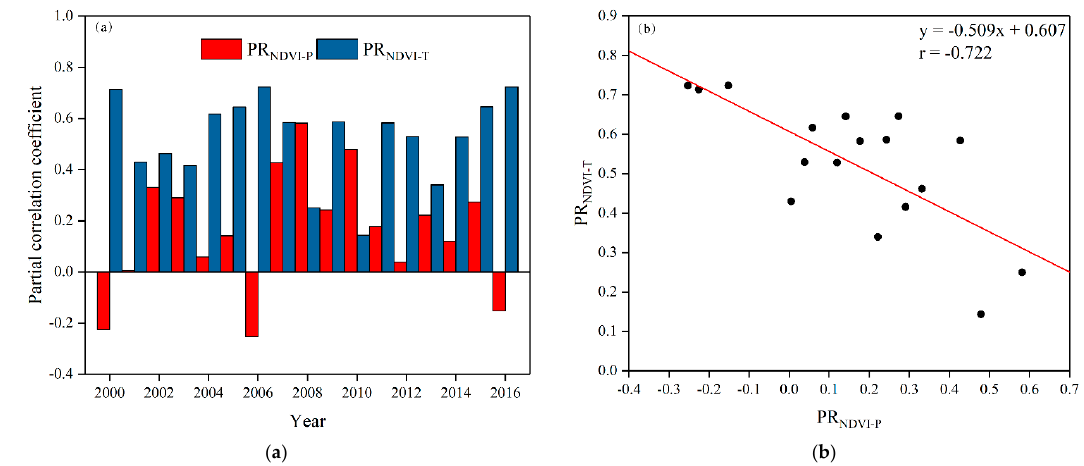
Figure 6. Inter-annual variations of the PR NDVI-P and PR NDVI-T ( a ) and scatter diagram ( b